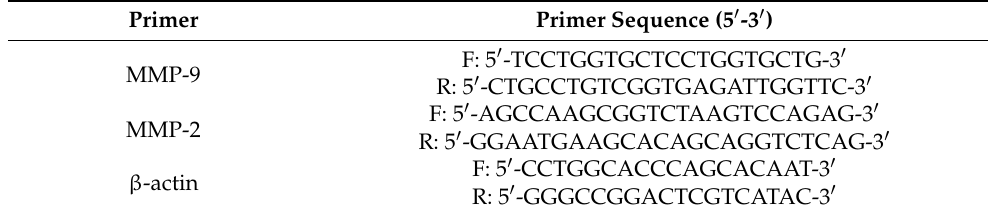
Table 1. Details of primers of qPCR